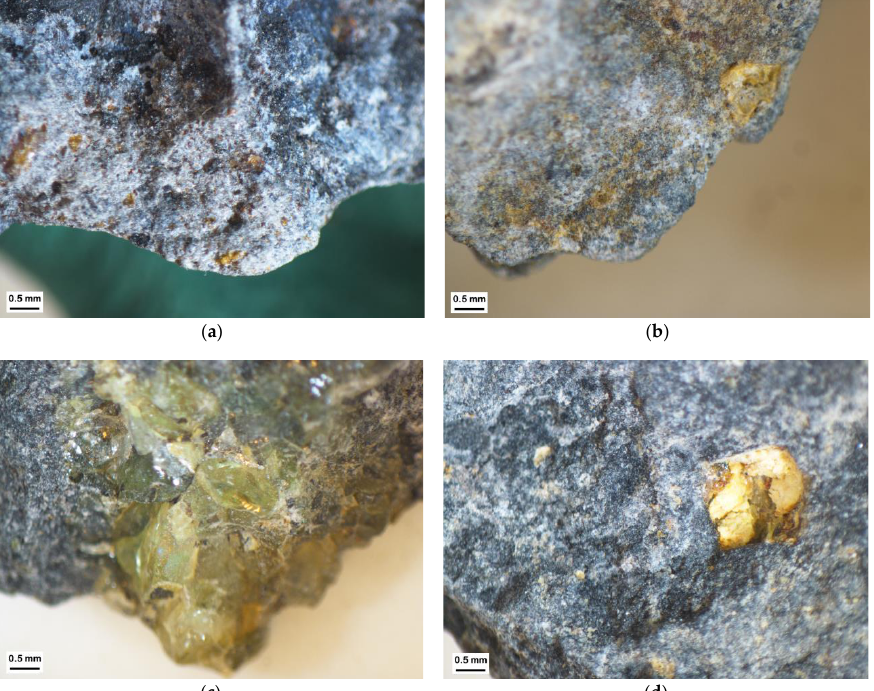
Figure A7. Characteristics of cracks in samples after crushing in cone crusher (feed — flaky grains): ( a ) Basalt aggregate 1, non-flaky grains, +8 mm; ( b ) Basalt aggregate 1, non-flaky grains, +16 mm; ( c ) Basalt aggregate 1, flaky grains, +8 mm; ( d ) Basalt aggregate 1, flaky grains, +16 mm.